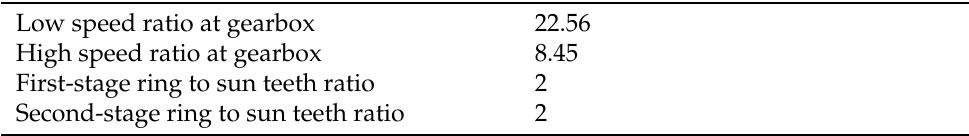
Table 4. Transmission ratios of HeCVT